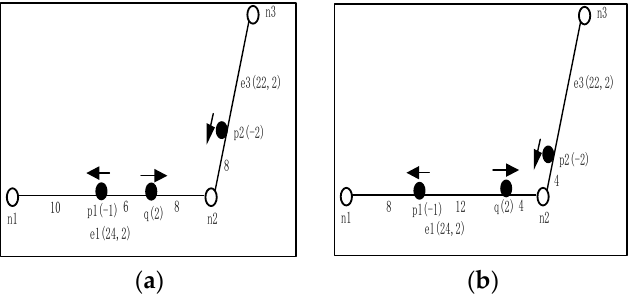
Figure 1. The local road network information under different timestamp: ( a ) at timestamp 0; ( b ) at timestamp 2.